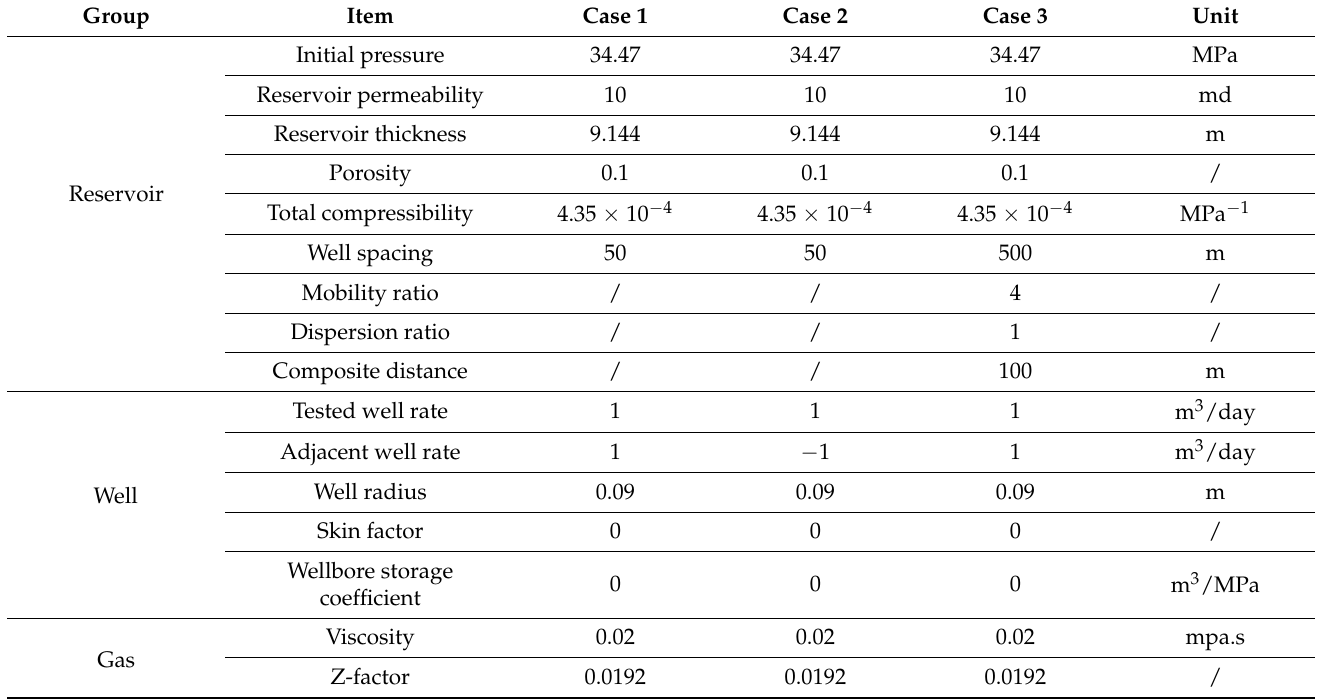
Table 3. The reservoir, well, and gas properties in the method verification.